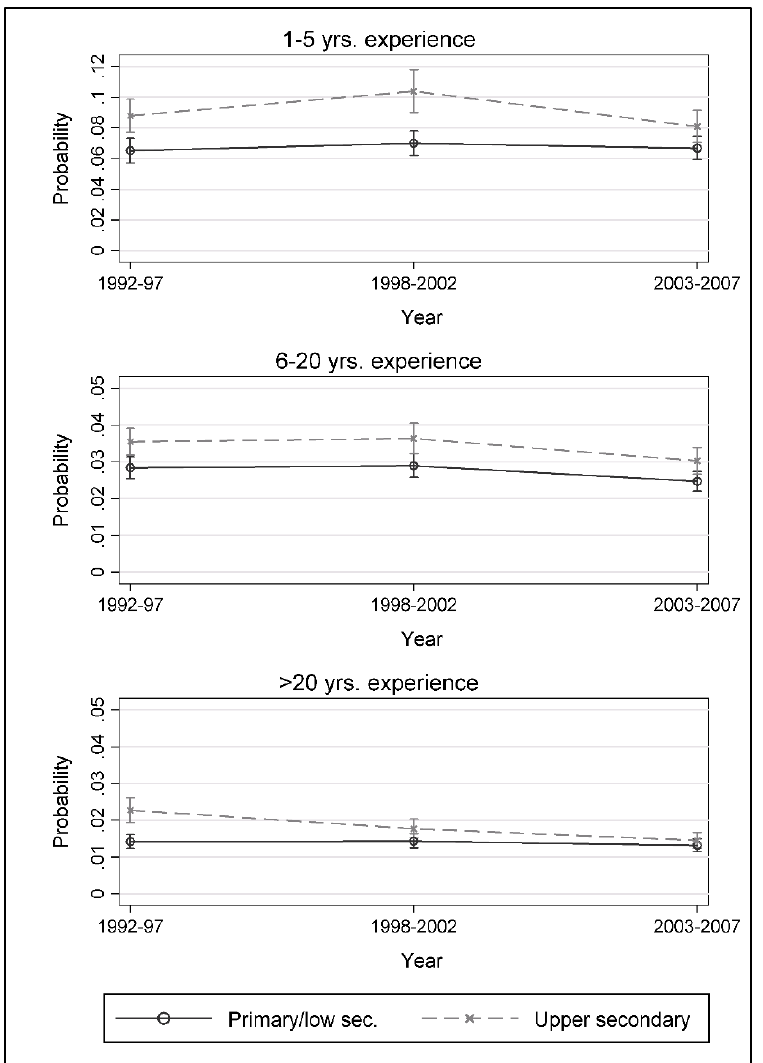
Figure 4. Annual attrition rates, exits to other employment (employment-exits), by school level in a previous year, time period, and career stage. 95% CI error bars. Predicted for female, no children < 8, bachelor’s graduate in humanities with PGCE, no further education, residing in central municipality, aged 35 (1-5 years’ experience), 45 (6-20 years’ exp.) or 55 (>20 years’